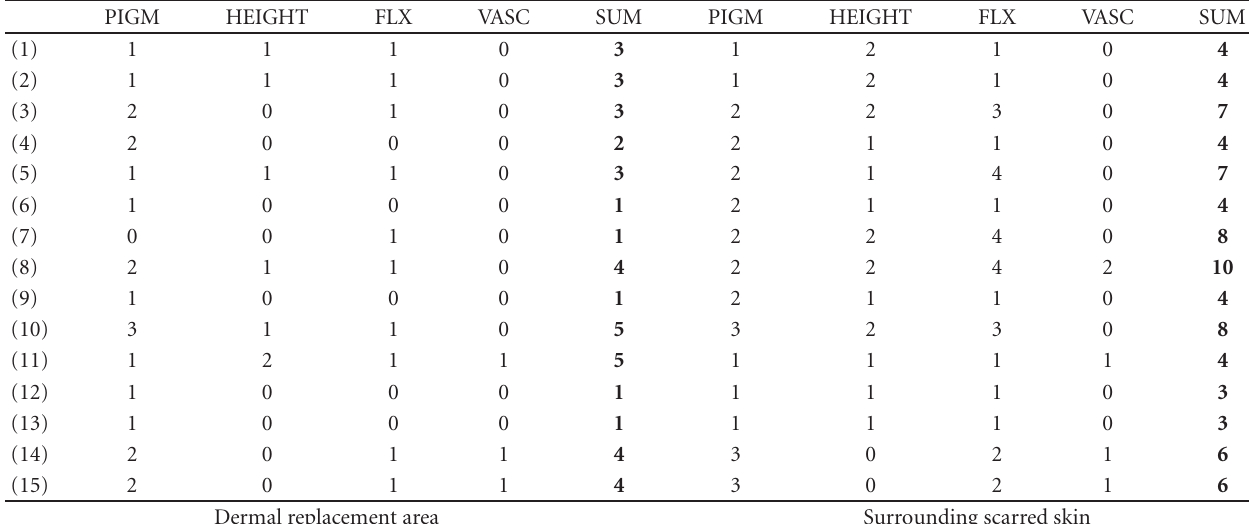
Table 3: Determination of scar qualities of the Alloderm implant sites and surrounding tissue by the modified Vancouver Burn Scar Index (VBSI).